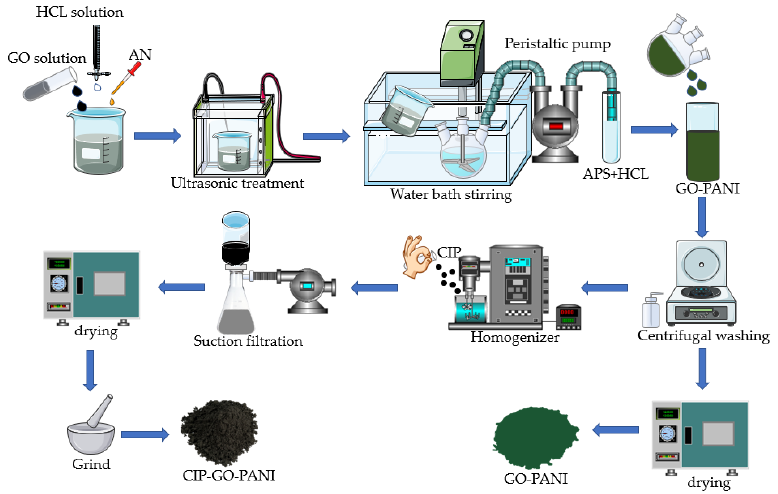
Figure 3. The schematic diagram of GO − PANI − CIP preparation.